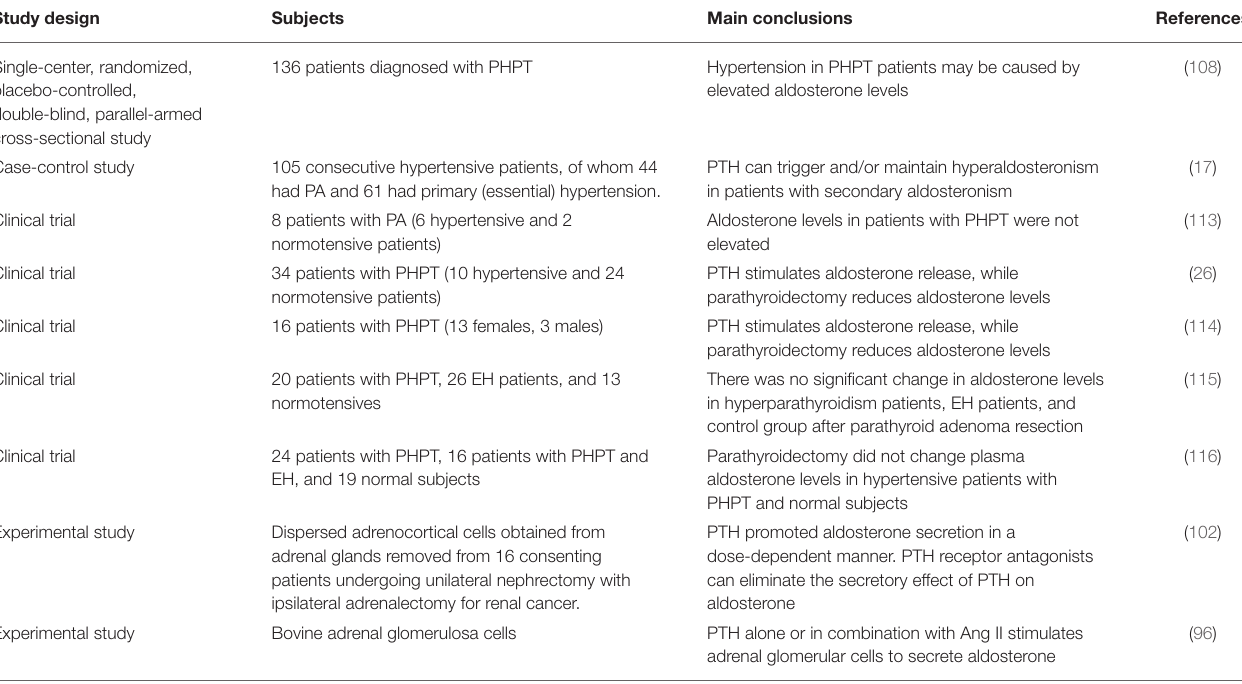
TABLE 1 | Representative studies on the effects of PTH on aldosterone